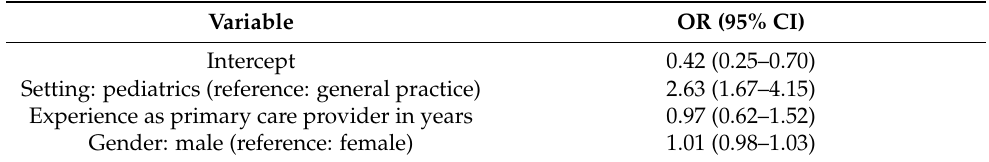
Table 3. The multivariable logistic regression on study participants ( n = 422) deeming HPVv “abso- lutely essential”. Abbreviations: confidence interval (CI); odds ratio (OR). Variable OR (95% CI)